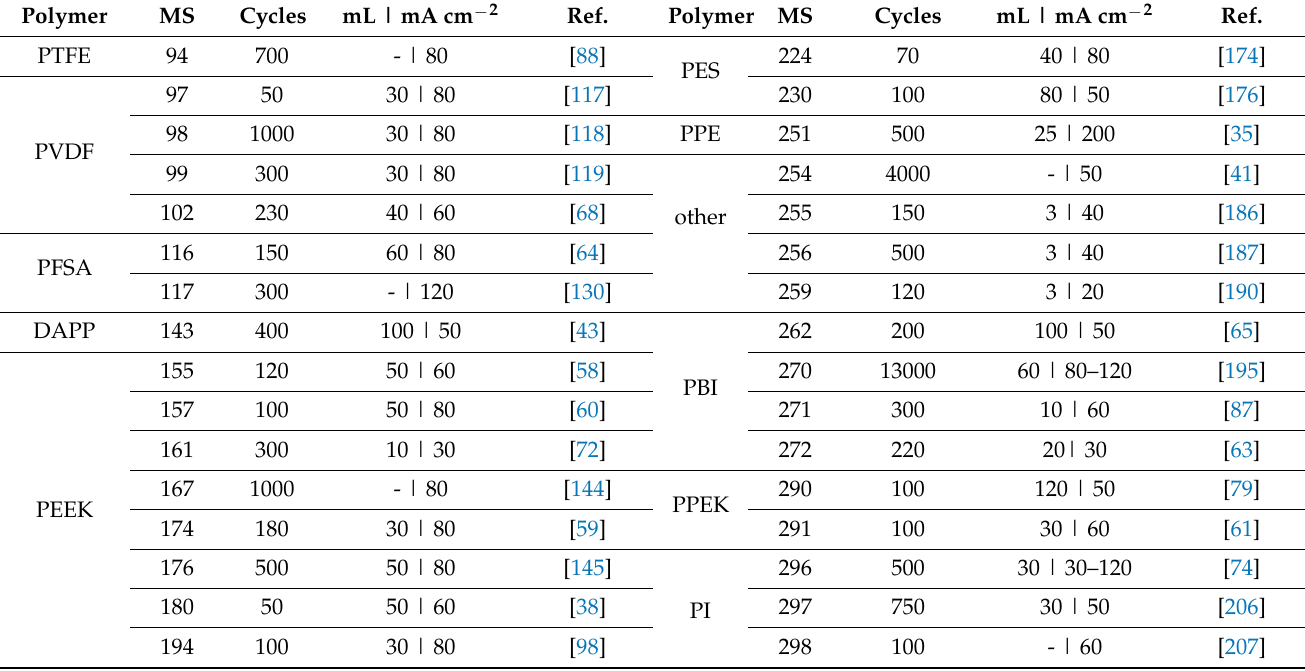
Table 16. Cycle stability of published membrane